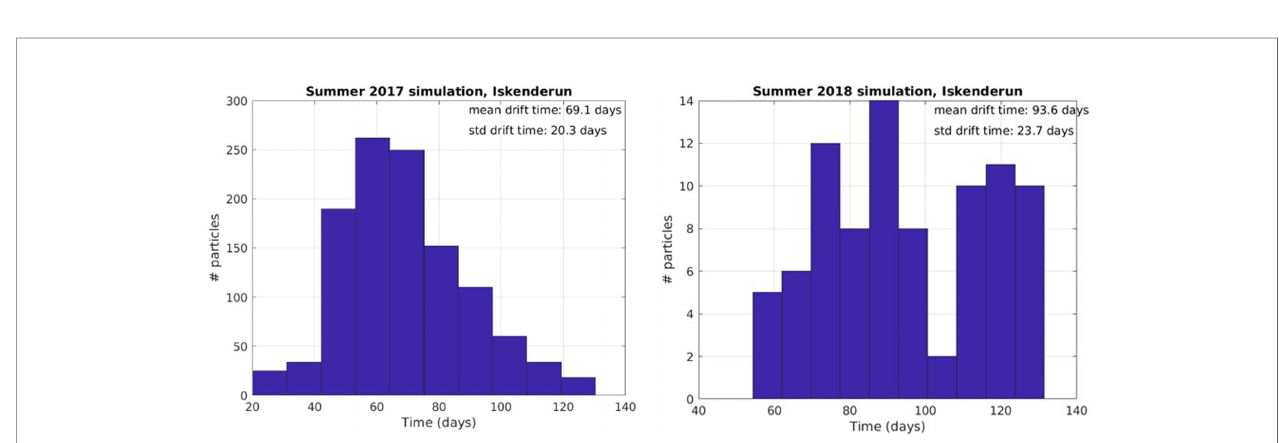
FIGURE 9 | Particle hit distribution on target beaches and mean drift time in days from release locations in Haifa region from April 18 th to August 31 st to Iskenderun, Turkey.